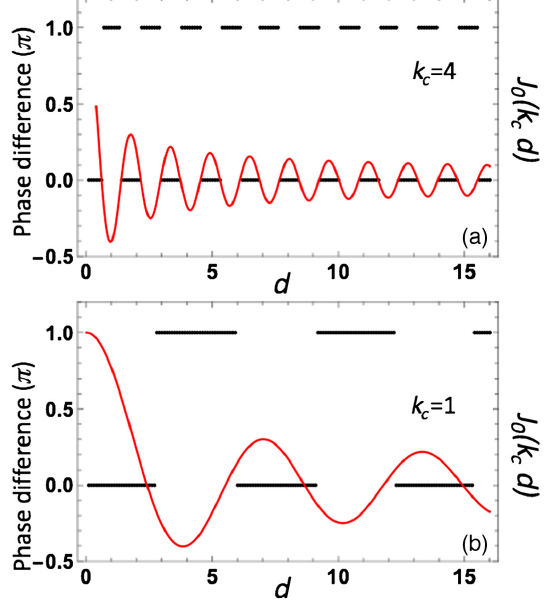
FIG. 6. The condensates flip from antisymmetric ( π phase difference) to symmetric states (zero phase difference), shown with black segments as a function of the separation distance for two values of the outflow wave number (a) k The solid red curves are the Bessel functions, J 0 ð k